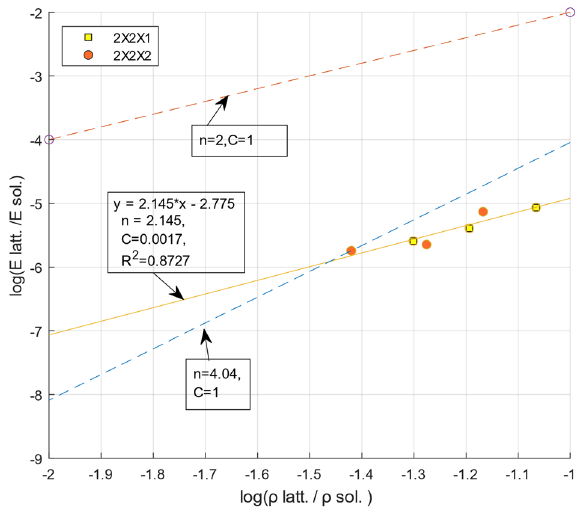
Figure 11. Scaling behavior of stiffness as a function of relative